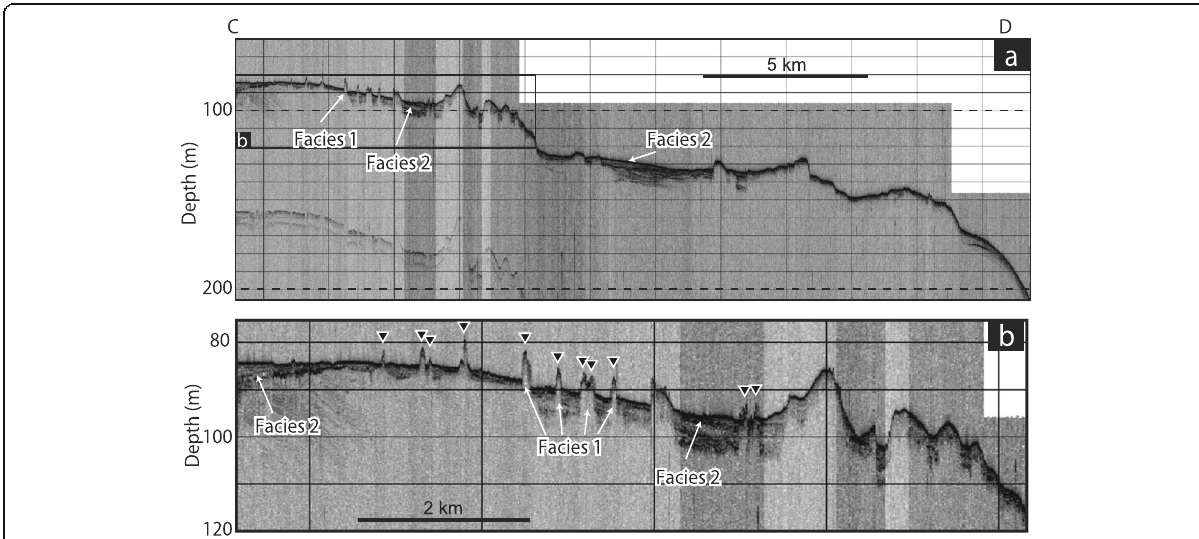
Fig. 4 SBP profiles off the eastern side of Miyako-jima (see Fig. 2 for the track location). This profile shows clear images of the mound-shaped structures. Inverted triangles indicate the mound-shaped